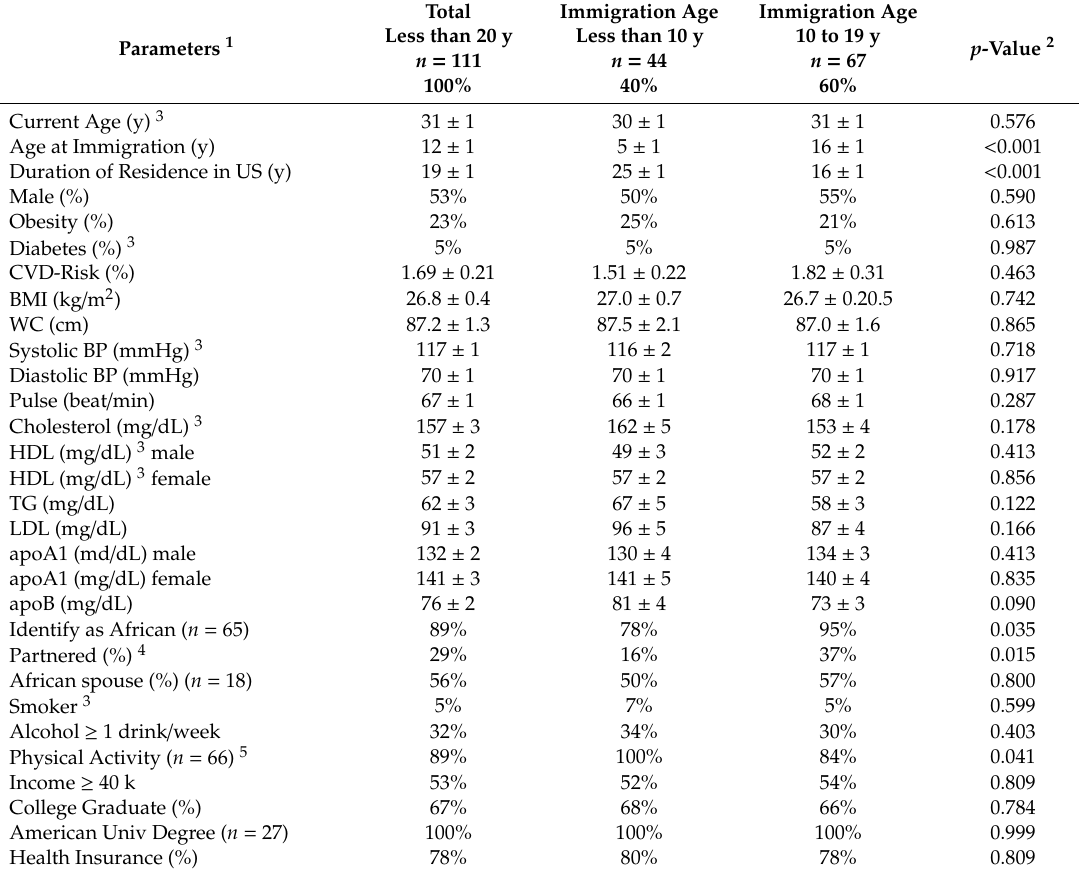
Table 2. Characteristics of the Immigration-Age < 20 y